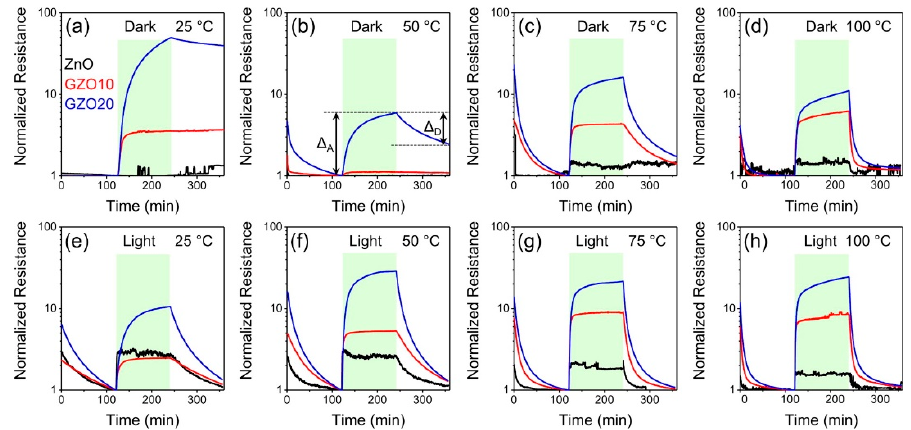
Figure 67. Normalized resistance changes to 400 ppb NO 2 (green shaded box) for ZnO and ZnO with various amount Ga doping (GZO10, GZO20) in dark ( a – d ) and with 460 nm visible light illumination ( e – h ) at temperatures ranging from 25 °C to 100 °C. Reproduced with permission from [98].